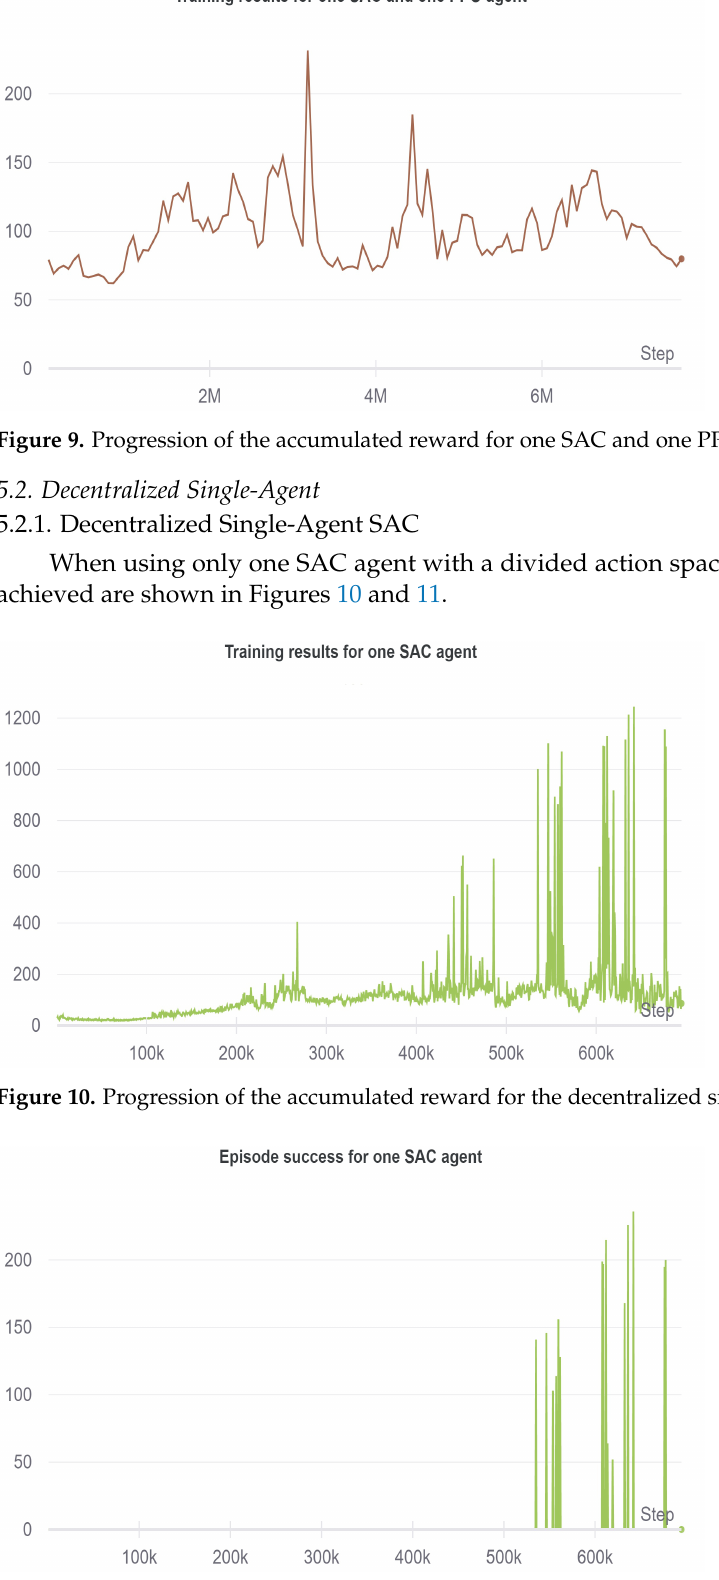
Figure 11. Episode success rate for the decentralized single-agent